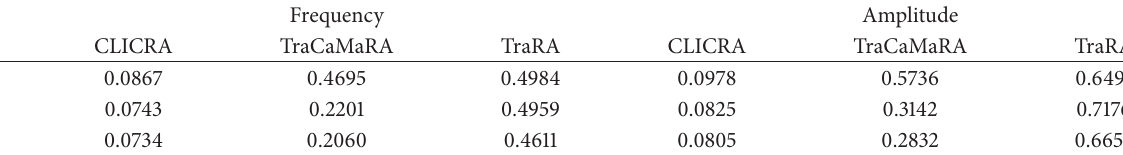
Table 4: Switch frequency and amplitude for receive window 1000 Kbytes.